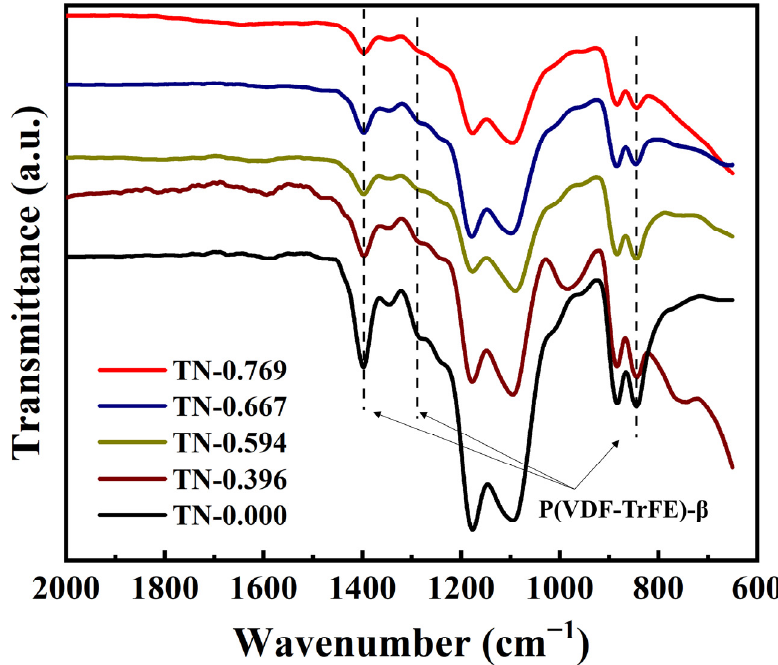
Figure 5. FTIR patterns of composite TN0.769, TN-0.667, TN-0.594, TN-0.396 and TN-0.000.